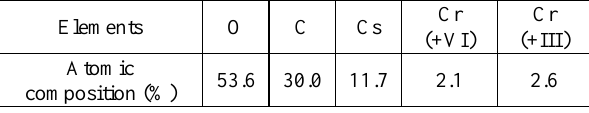
Table II: XPS surface composition after revaporization at 520 °C Elements